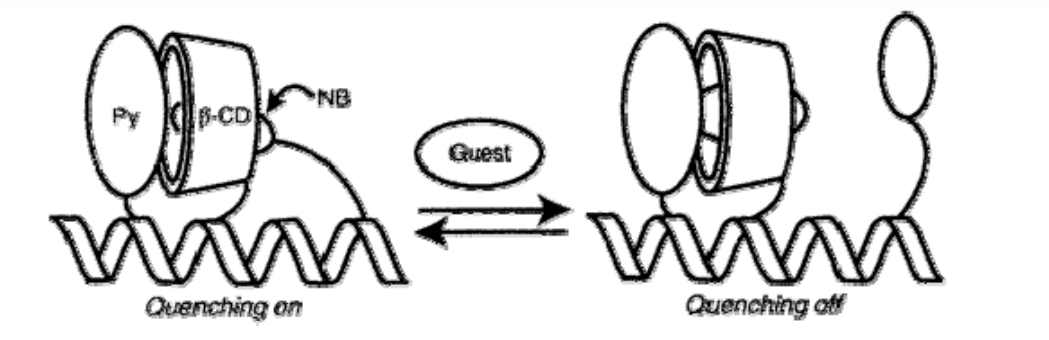
Figure 4. Schematic representation of a scaffold-based biosensor with β -cyclodextrin ( β -CD) acting as the recognition element. Upon binding of the analyte (guest), the quencher nitrobenzene (NB) is displaced from the β -CD binding site and the emission from the fluorophore (pyrene, Py) is enhanced. From [63], with permission from the American Chemical